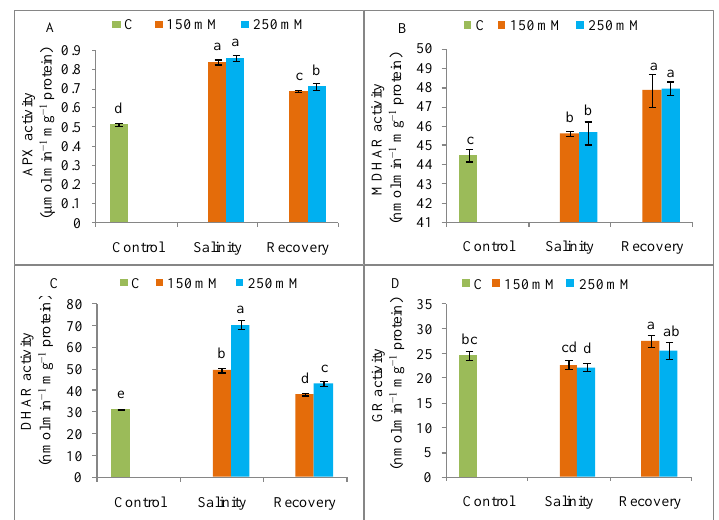
Figure 12. Activities of ascorbate peroxidase (APX) ( A ), monodehydroascorbate reductase (MDHAR) ( B ), dehydroascorbate reductase (DHAR) ( C ), and glutathione reductase (GR) ( D ) in tomato plants under salinity (150 and 250 mM NaCl) and after a 48 h recovery period. Data means ( ± SD) were calculated from three replications. Statistically significant values are indicated by dissimilar letters (Fisher’s LSD test, P ≤ 0.05).